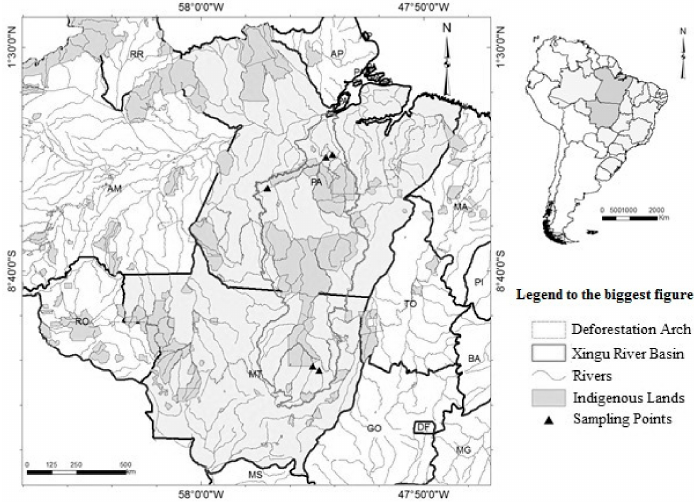
Figure 1. Map of the sampling localities in the Xingu River Basin of Mato Grosso and Par á States, Brazil (black